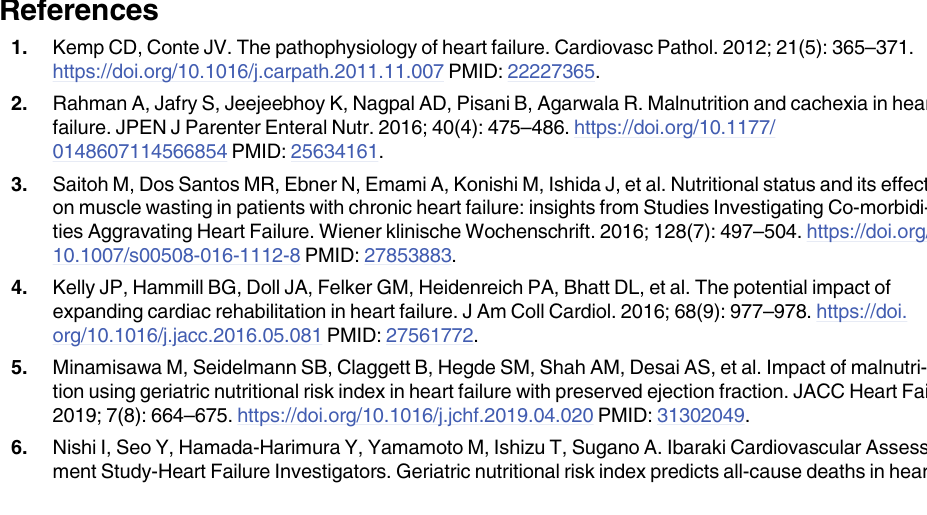
S4 Table. Meta regression analysis of malnutrition prognosis in patients with chronic heart failure. S5 Table. Prognosis of malnutrition among different subgroups. S1 Fig. Literature sensitivity analysis of malnutrition prevalence in patients with chronic heart failure. S2 Fig. Literature sensitivity analysis of malnutrition prognosis in patients with chronic heart failure. S3 Fig. Funnel plot generated by Begg test (prevalence). S4 Fig. Funnel plot generated by Egger test (prevalence). S5 Fig. Funnel plot generated by Begg test (prognosis). S6 Fig. Funnel plot generated by Egger test (prognosis). S7 Fig. Funnel plot of literature publication bias on malnutrition prognosis in patients with chronic heart